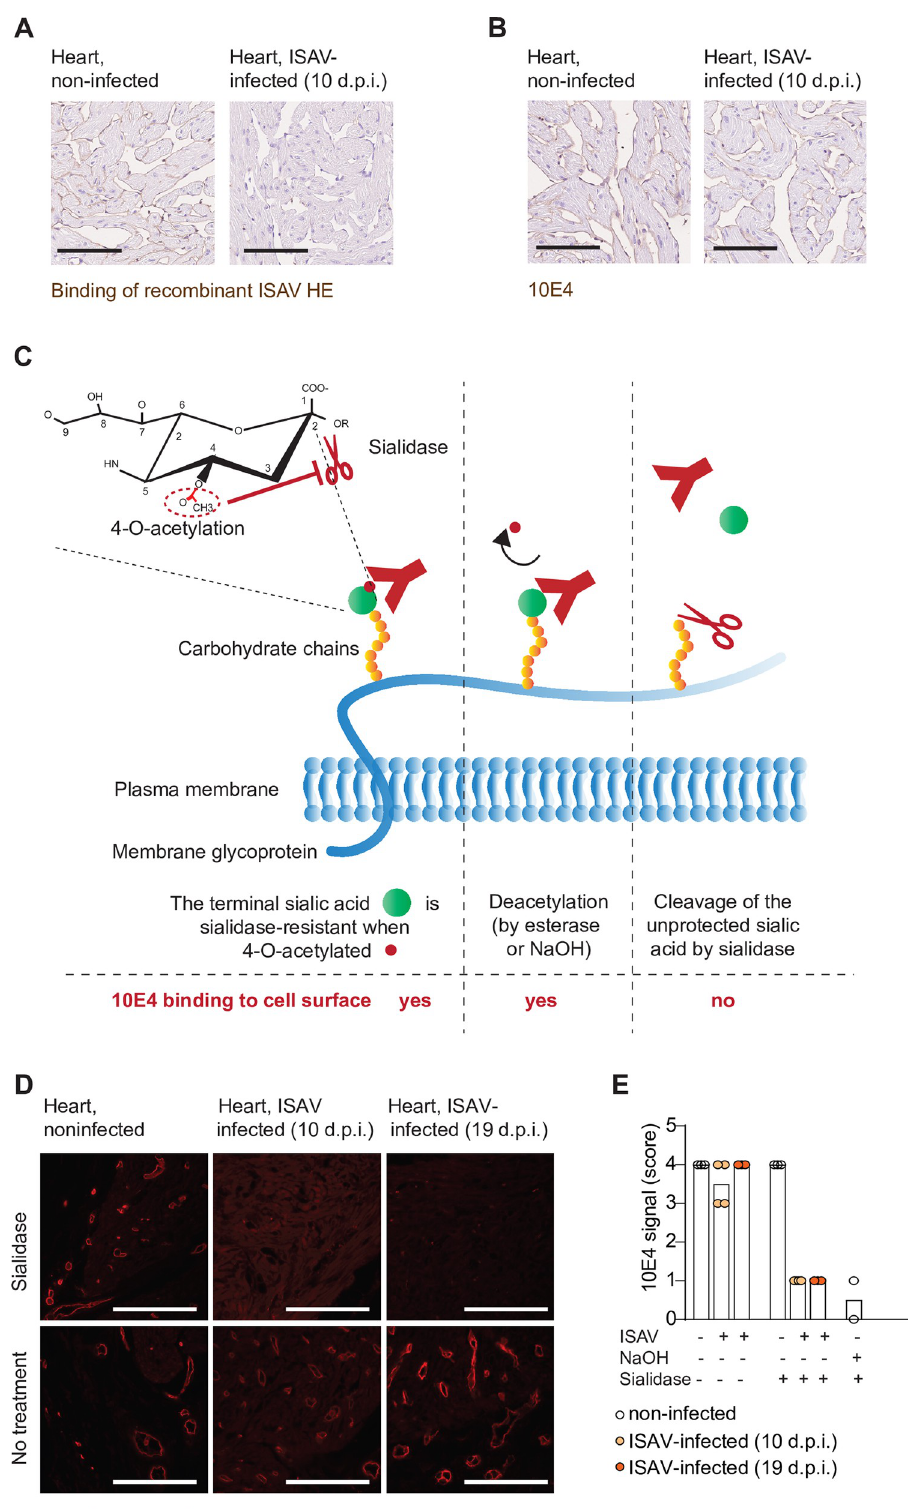
Fig 2. Vascular sialic acids are preserved in infected fish, but lose the 4- O -acetylation that constitutes the ISAV receptor. (A) Binding of recombinant ISAV HE (brown) in heart of non-infected and Glesvaer/2/90-infected fish.